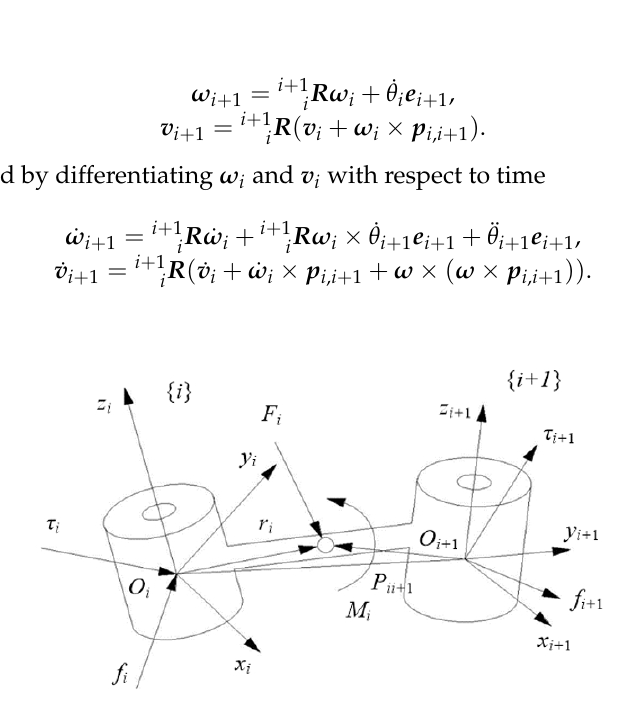
Figure 3. Definitions of the link parameters. Table 2. Parameters used in